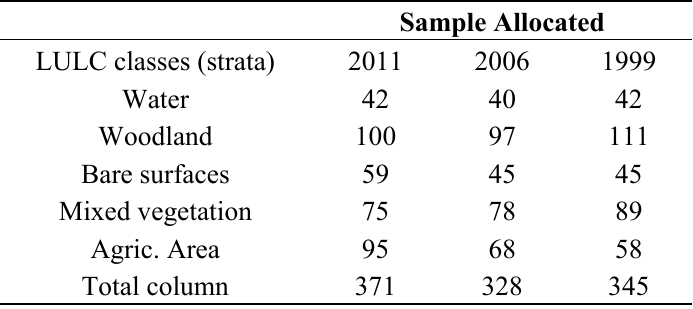
Table 7. Sample size allocated to each LULC class in 1999, 2006 and 2011.